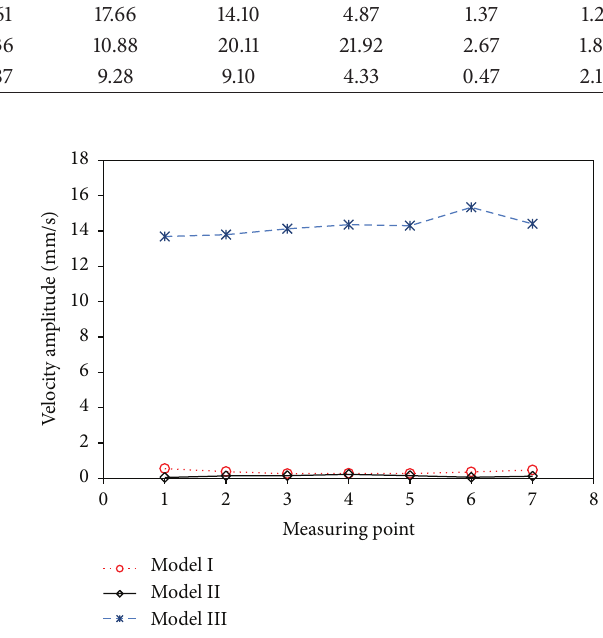
Figure 6: Velocity amplitudes at H 1 –H 9 for Models I, II, and III subjected to base excitation at 100Hz.